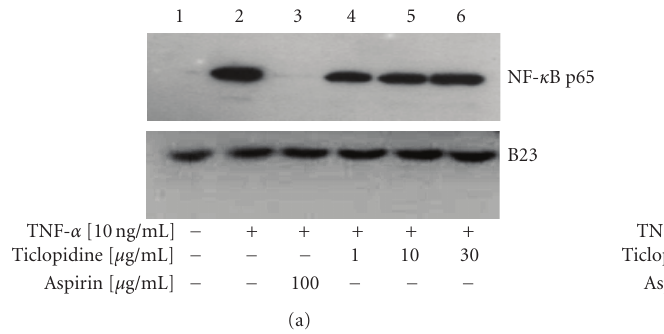
Figure 6: Ticlopidine has no e ff ect on NF-kB activation. HUVECs were incubated with di ff erent concentrations of ticlopidine, and 100 μ g/mL of aspirin was added as the control. Cells were stimulated with/without TNF- α (10ng/mL) for 30 minutes, nuclear and cytosolic proteins were collected. Briefly, the nuclear protein extracts were collected, and western blots were performed using anti-NFkB p65 and anti-B23 Ab (a). Cytosolic protein extracts were collected, and western blots were performed using anti-Ik-B- α and α -tubulin Ab (b). Lane 1, without TNF- α ; lane 2, TNF- α (10ng/mL) alone; lane 3, TNF- α + aspirin (100 μ g/mL); lane 4, TNF- α + ticlopidine (1 μ g/mL); lane 5, TNF- α + ticlopidine (10 μ g/mL); lane 6, TNF- α + ticlopidine (30 μ g/mL). Results are representative of one of three independent